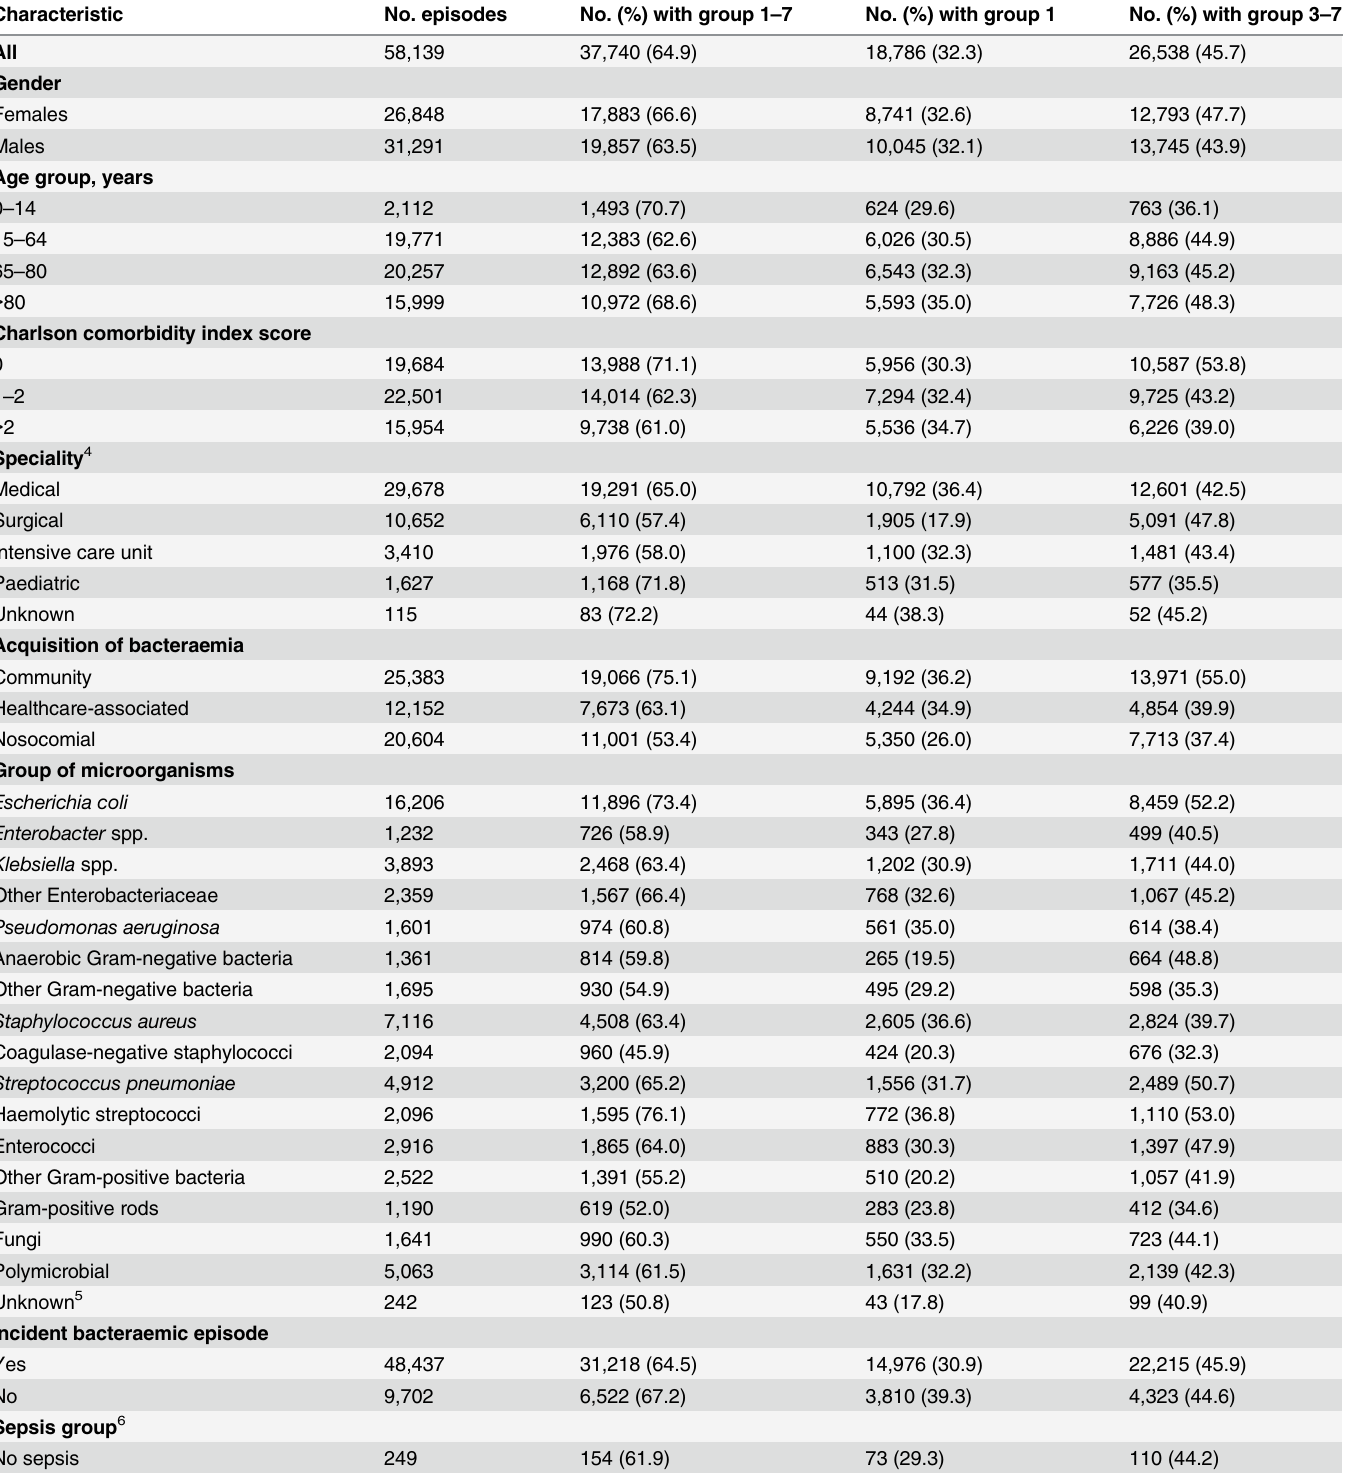
Table 3. Patient characteristics in relation to groups of diagnosis/surgical procedure codes that indicate hospitalization with bacteraemia or the presence of a focal infection.